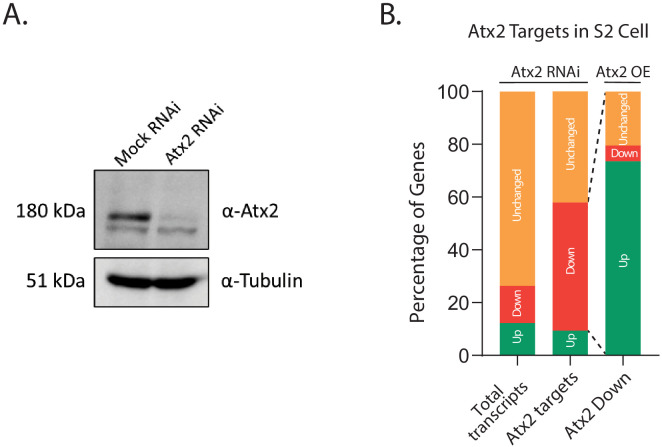
Altering levels of Atx2 in S2 cells affects the levels of target mRNAs.(A) Knockdown of Atx2 using dsRNA in S2 cells. Western blots with anti-Atx2 antibody and anti-tubulin show significant reduction in Atx2 levels. (B) Knockdown of Atx2 in S2 cells destabilizes majority of its Targets of RNA-Binding Proteins Identified by Editing targets, which are stabilized in overexpression, indicating a role for Atx2 is target stabilization.
Figure 3—figure supplement 5—source data 1.Fold changes in Atx2-target mRNAs when Atx2 is overexpressed or knocked down in S2 cells.